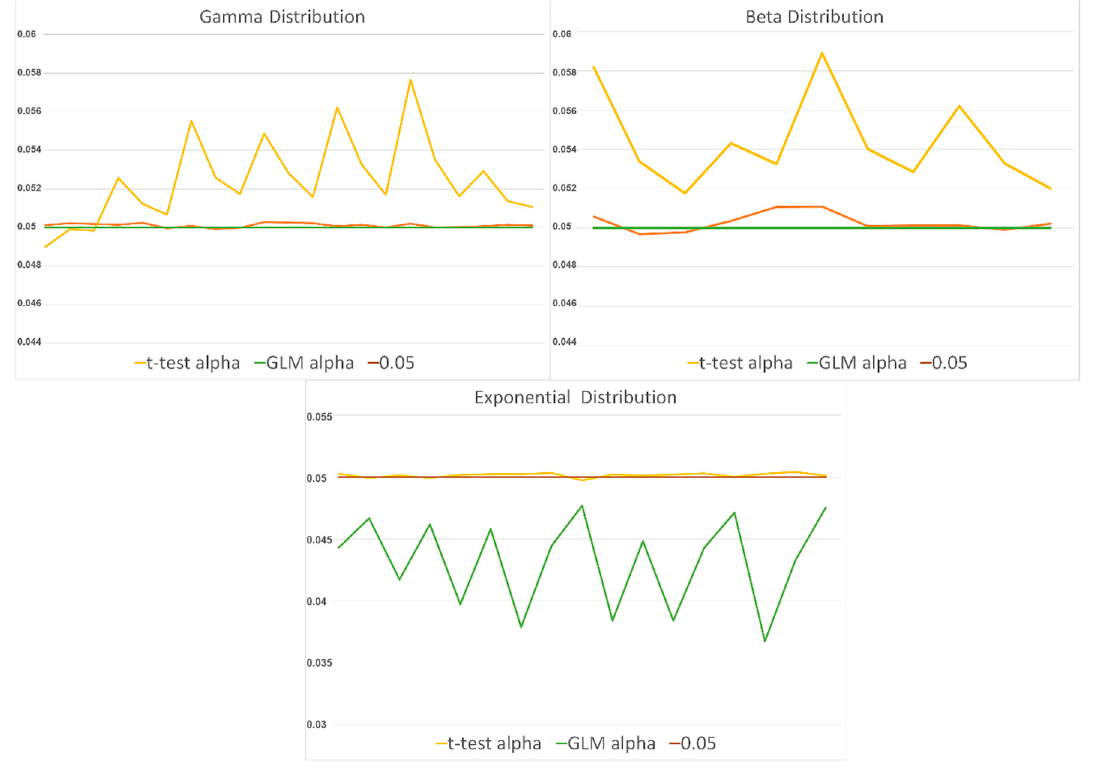
Figure 3. Type I error rates for the t -test and GLM compared to 0.05 for the three distributions.